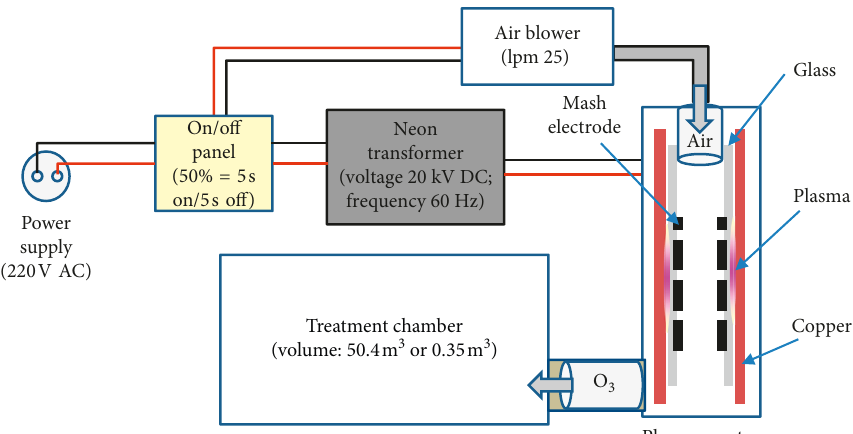
Figure 1: Schematic diagram of corona discharge air plasma (CDAP) system. 50.4m 3 is the generated plasma in a low-temperature storage room. 0.35m 3 is the scale of the device installed to check the degree of the inhibition of the microbial isolated from the onion.